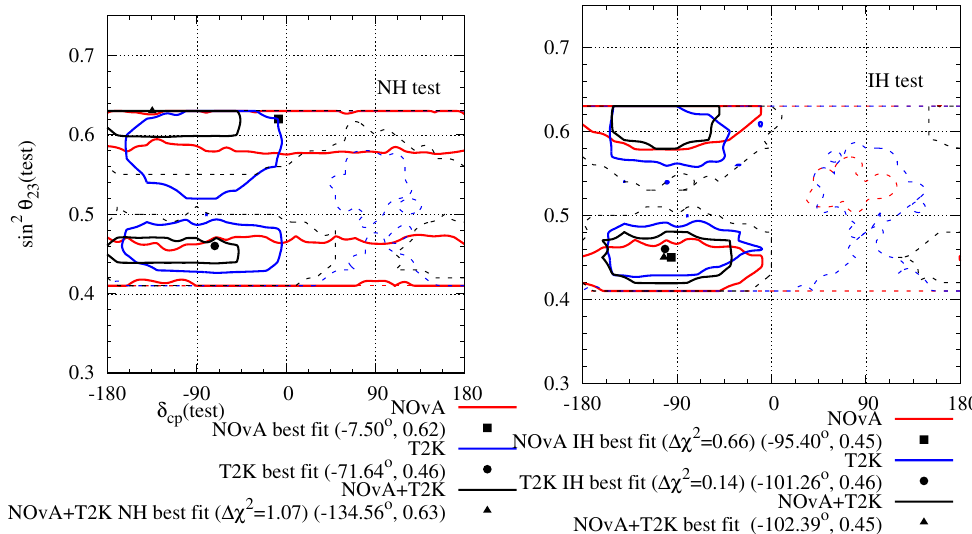
Figure 7. Allowed region in the sin 2 θ 23 − δ CP plane after analysing NO ν A and T2K complete data set with non-unitary hypothesis. The left ( right ) panel represents test hierarchy NH (IH). The red (blue) lines indicate the results for NO ν A (T2K) and the black line indicates the combined analysis of both. The solid (dashed) lines indicate the 1 σ (3 σ )-allowed regions. The minimum χ 2 for NO ν A (T2K) with 50 (88) bins is 45.88 (93.36) and it occurs at NH. For the combined analysis, the minimum χ 2 with 138 bins is 142.72.